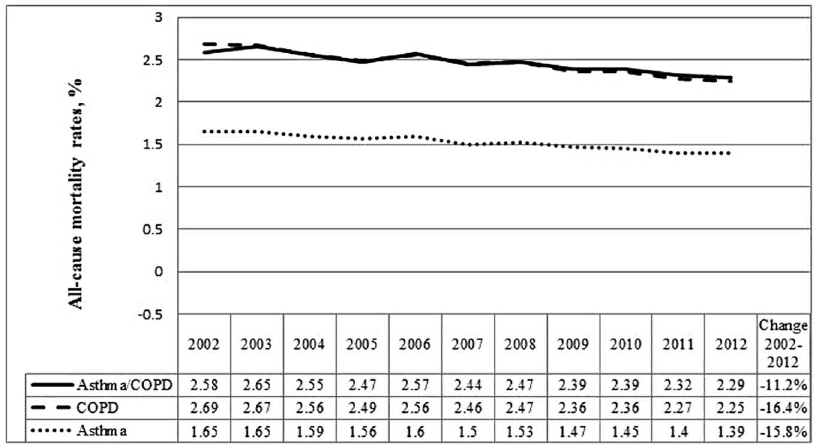
Fig 3. All-cause mortality standardized rates (%) by age and sex for COPD, asthma and concurrent physician-diagnosed asthma and COPD over time among adults 35 yearsand older in Ontario,